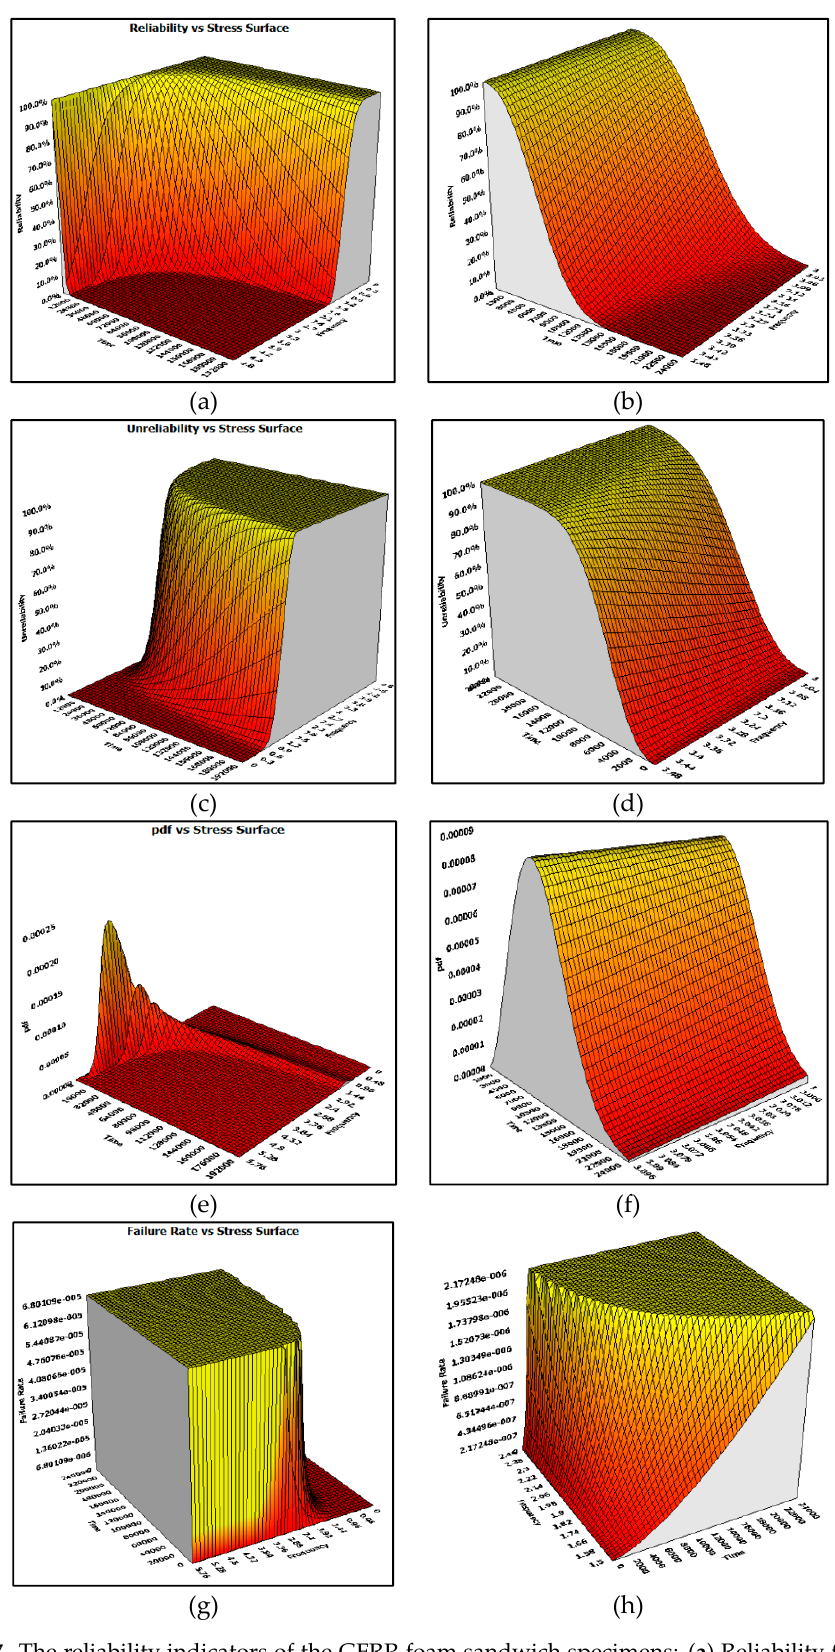
Figure 7. The reliability indicators of the GFRP-foam sandwich specimens: ( a ) Reliability function; ( b ) local amplification of the reliability function; ( c ) unreliability function; ( d ) local amplification of the unreliability function; ( e ) probability density function; ( f ) local amplification of the probability density function; ( g ) failure rate; ( h ) local amplification of the failure rate.